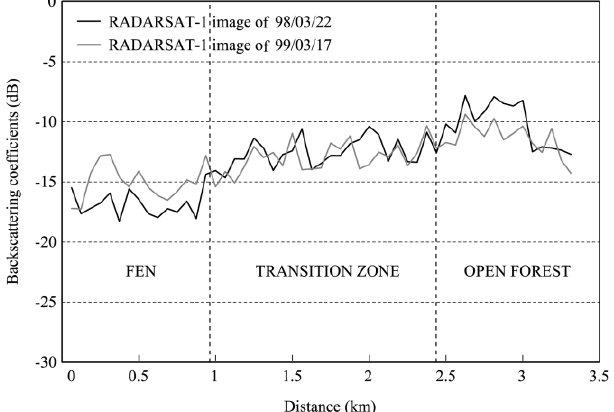
Figure 6. The RADARSAT-1 backscatter variations along two transects successively crossing the sedge fen, transition zone, and open spruce forest near the Twin Lakes during the period of maximum snow accumulation in the winters of 1997/98 and